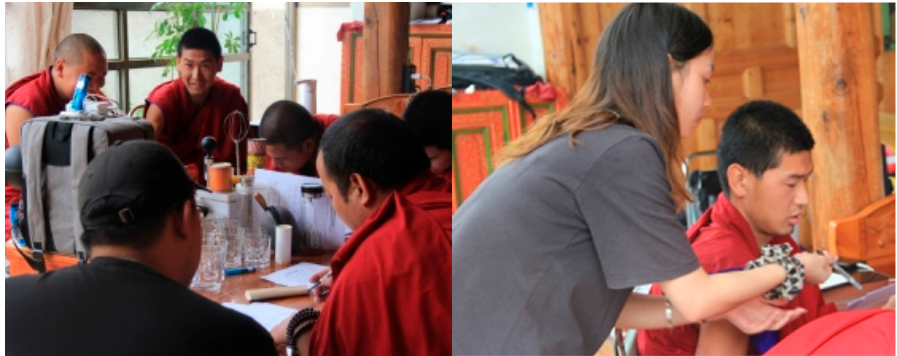
Figure 7. Picture of field measurements (source: self-taken).